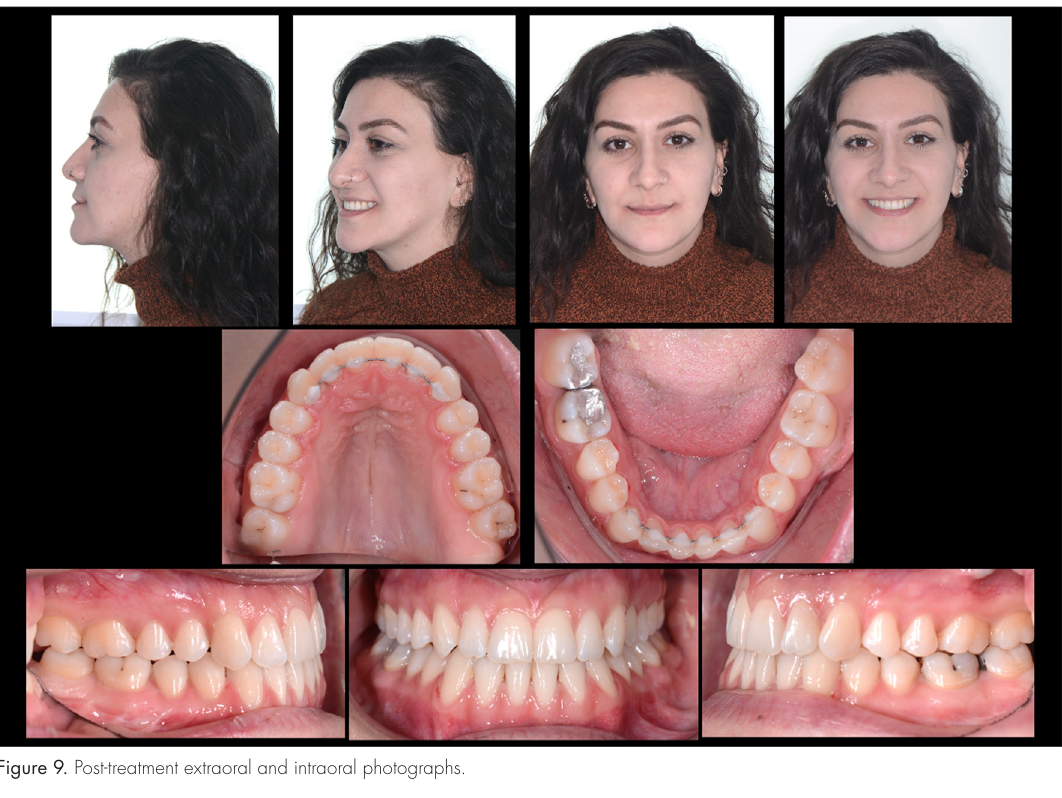
Figure 9. Post-treatment extraoral and intraoral photographs.